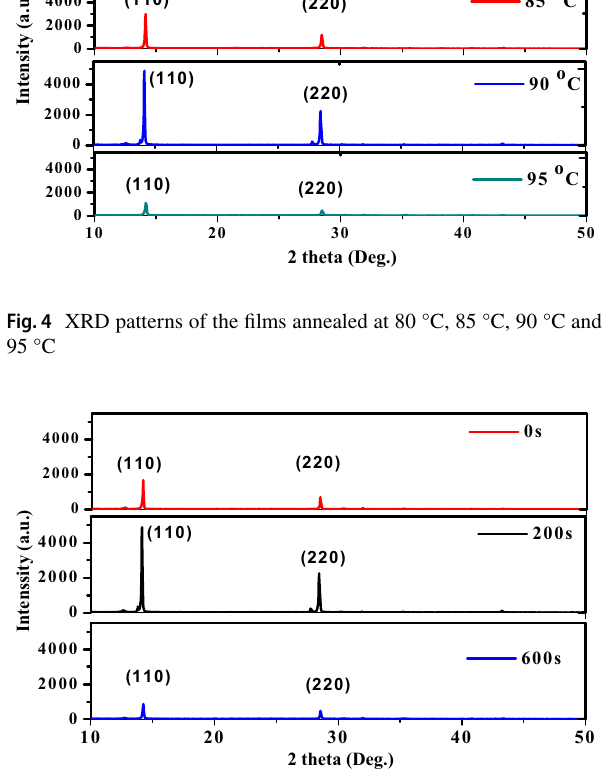
Fig. 5 XRD patterns of the films aged at 0 s, 200 s, and 600 s before annealing at 90 °C for 5